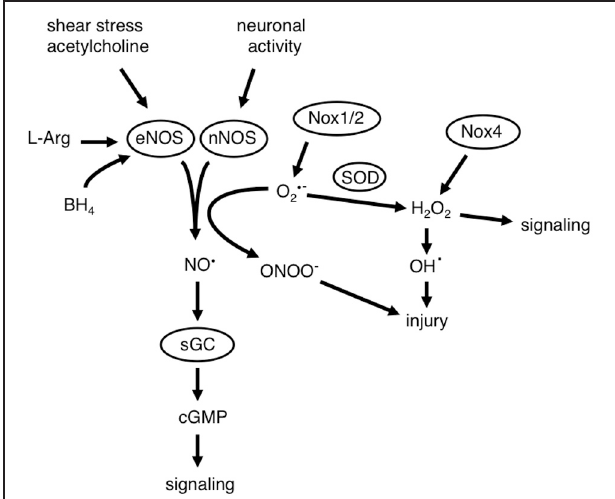
FIGURE 1 | Interactions between nitric oxide (NO · ) and reactive oxygen species (ROS). NO · is a critical component of mechanisms that regulate cerebrovascular homeostasis. Diverse stimuli (including shear stress, neurotransmitters like acetylcholine and activation of neurons) can result in the generation of NO · by either endothelial or neuronal nitric oxide synthase (eNOS and nNOS, respectively). The generation of NO · is dependent on the presence of the substrate L-arginine (L-Arg) and enzyme co-factors including tetrahydrobiopterin (BH 4 ). NO · activates its receptor in vascular muscle soluble guanylate cyclase (sGC), which results in the formation of cyclic guanosine monophosphate (cGMP). This results in numerous signaling events and functional effects which include cerebral vasodilation. NADPH oxidases (Nox1 and Nox2) generate superoxide (O 2 ·− ) and Nox4 can generate hydrogen peroxide (H 2 O 2 ), ROS can then participate in signaling events, but may also cause cellular injury. O 2 ·− is a potent scavenger of NO · , which reduces the bioavailability of NO · and results in the formation of peroxynitrite (ONOO − ), which also causes cellular